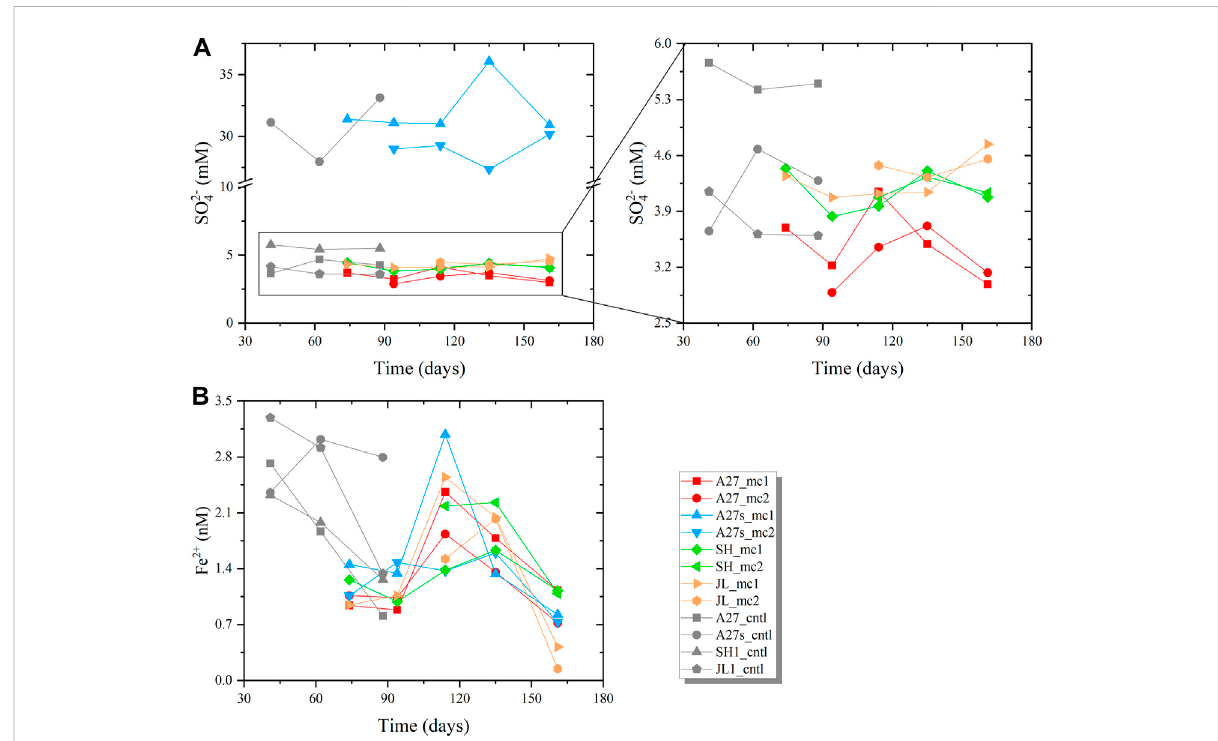
FIGURE 3 Time course of (A) the measured SO2- 4 concentrations and (B) Fe 2+ concentrations in the supernatant liquid. The enlarged graph in (A) on the right shows the detailed changes observed in incubations with treated bottom seawater. Because the incubation scheme was modi fi ed, the supernatant of the control groups was only sampled three times, and the sampling times were inconsistent with the experimental